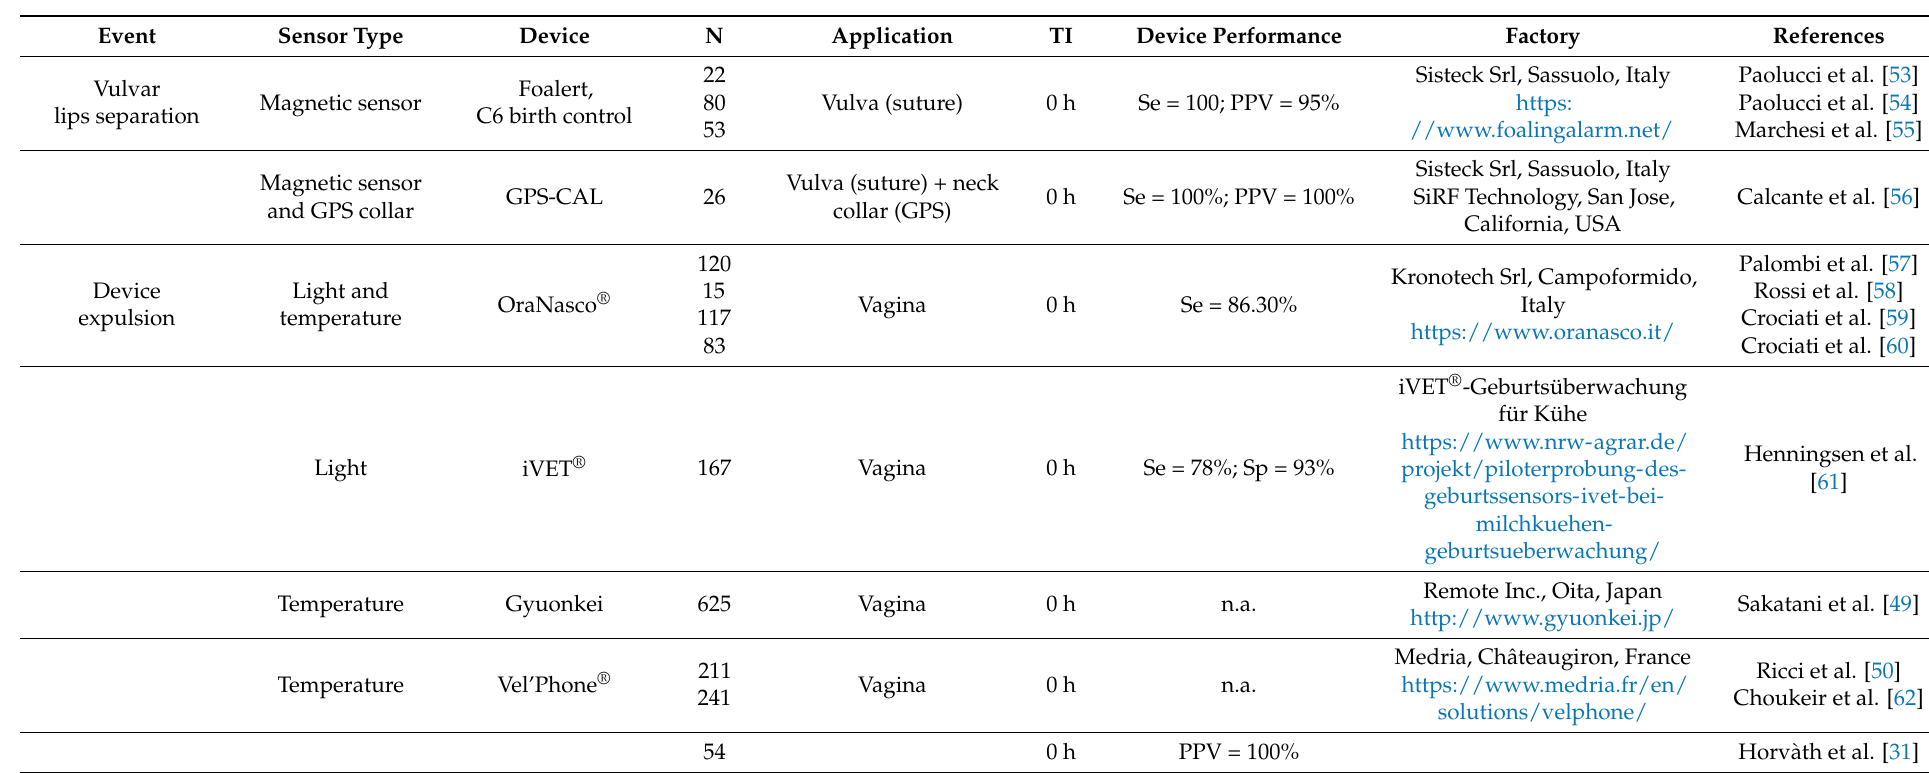
Table 5. Devices for calving alarm which identify the onset of stage II of parturition, with performance and